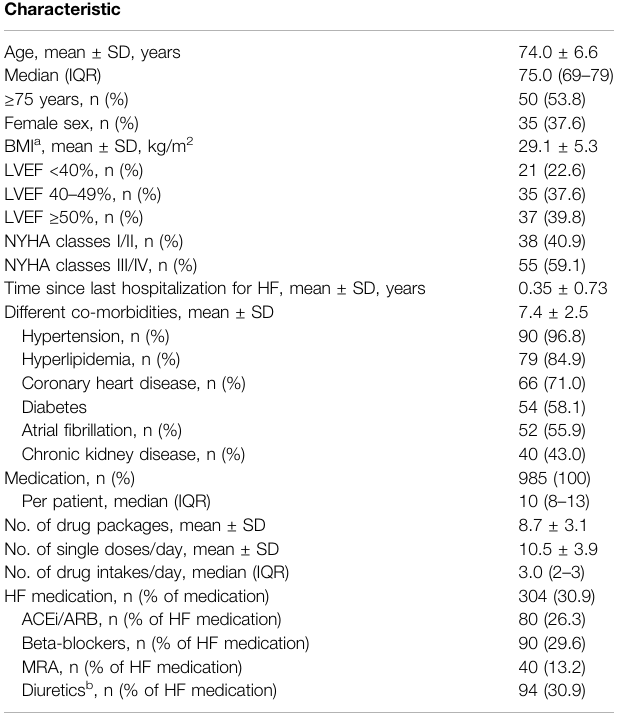
TABLE 1 | Baseline characteristics of the analyzed patients ( n (cid:1) 93).